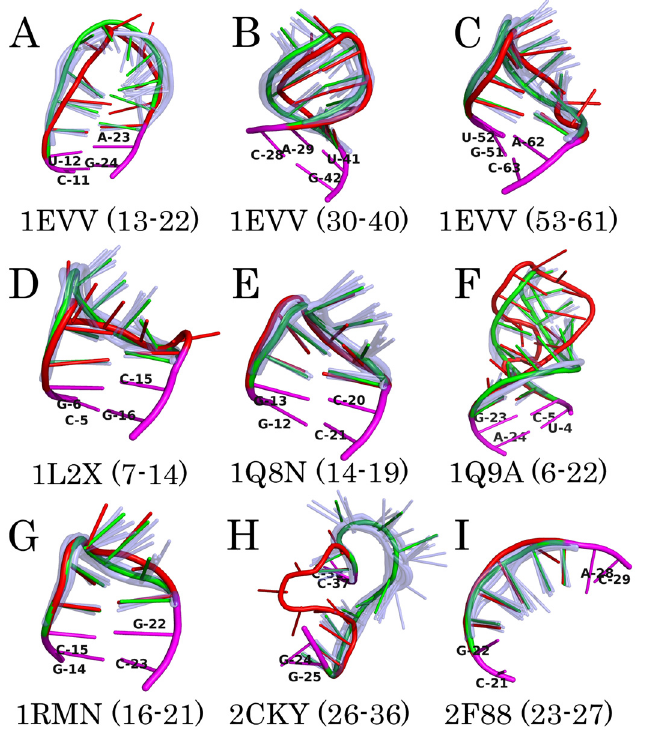
Fig 5. Superposition of the predicted and the experimental structures of nine loops, shown in the same order as in Table 1. The red cartoons represent the experimental conformations. For each loop, the light-blue and semi-transparent cartoons are the first 20 structures in the largest cluster, whose central structure is shown by the green cartoon. The magenta cartoons mark the anchor nucleotides.